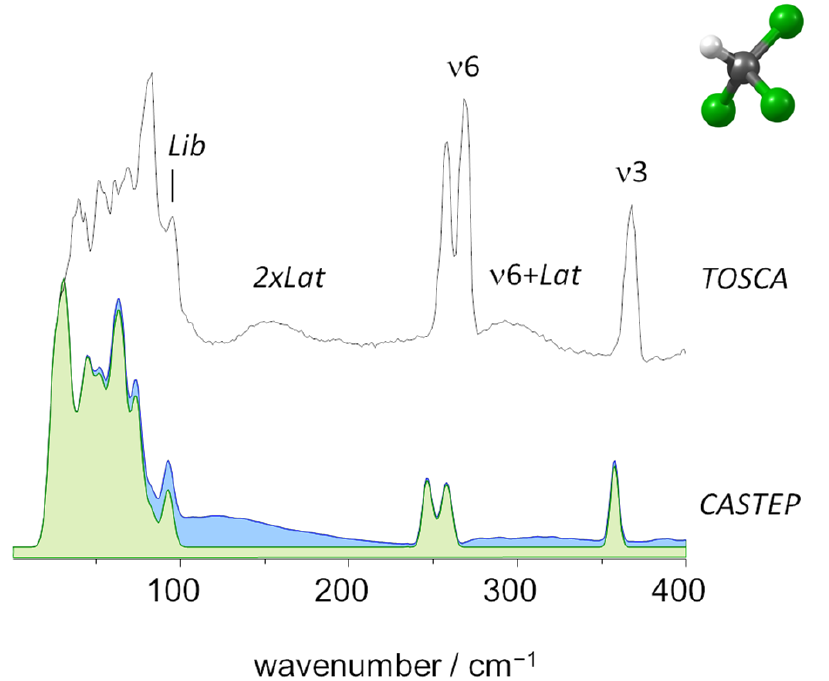
Figure 3. The INS spectra of trichloromethane (chloroform) in the low wavenumber region, up to 400 cm − 1 : Experimental (top, TOSCA) and simulated from periodic calculations (bottom, CASTEP). Colors indicate the intensity contributions from fundamental modes (green) and two-quanta events (blue).